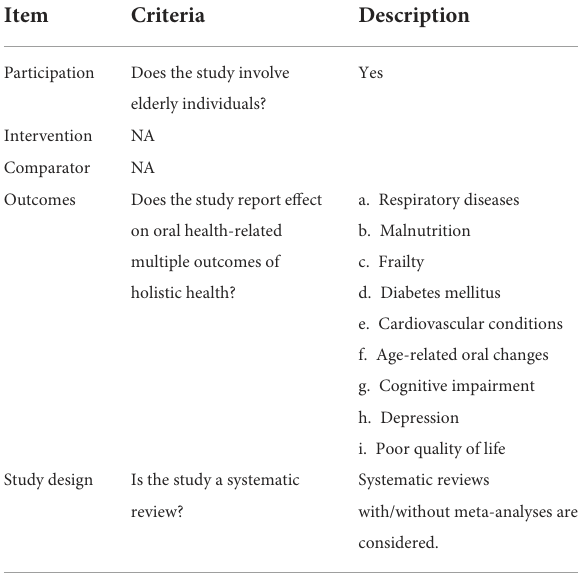
TABLE 1 PICOS criteria for inclusion of